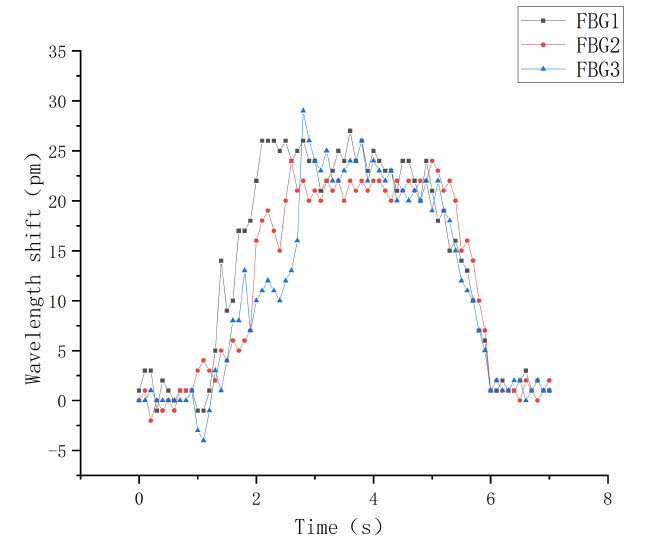
Figure 32. Slip response